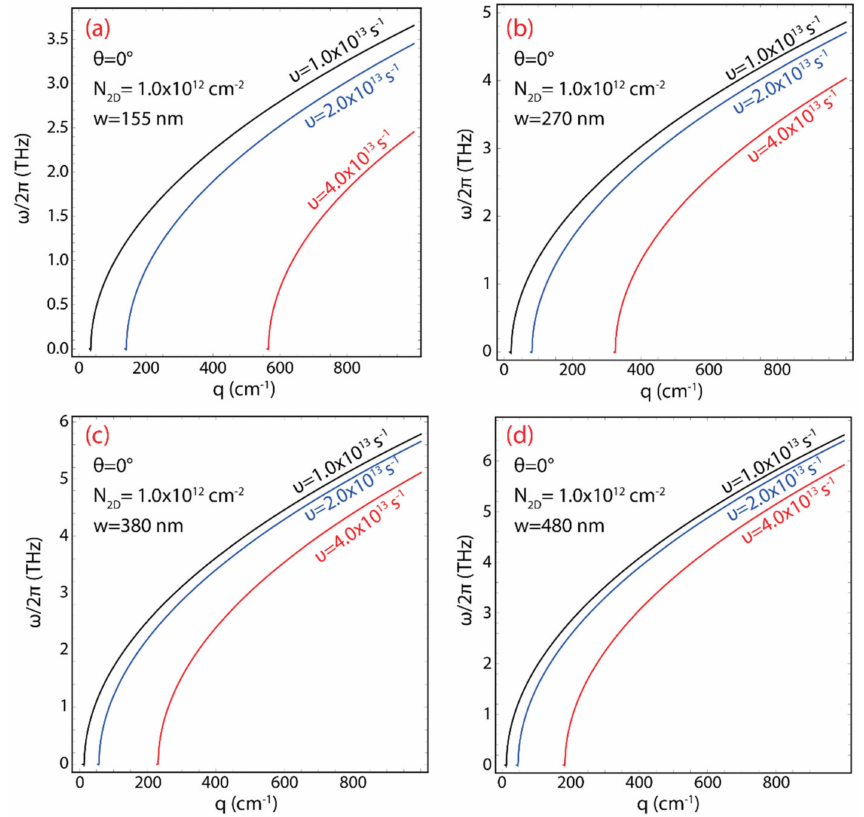
Figure 7. Plasmon frequency–momentum dispersion of 2D GNR arrays of interest, considering different values of electron relaxation rate ( ν = 1.0 × 10 13 , 2.0 × 10 13 , 4.0 × 10 13 s − 1 ): ( a ) w = 155 nm, ( b ) w = 270 nm, ( c ) w = 380 nm, and ( d ) w = 480